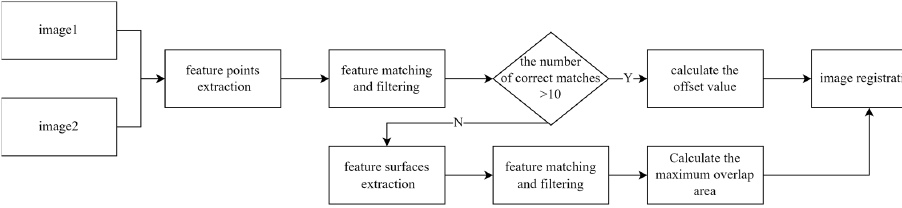
Figure 1. Tile map registration flowchart.